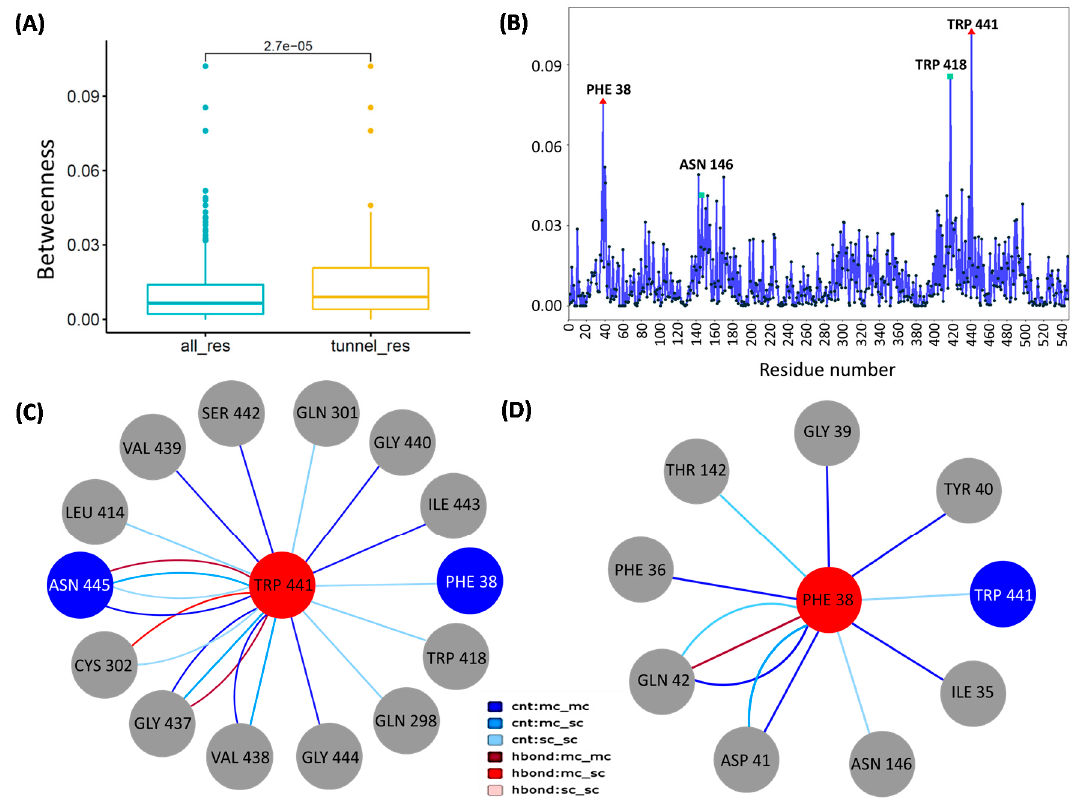
Figure 6. Analysis of residue interaction networks of CCM_06358. Note: ( A ) The distributions of betweenness for all residues and tunnel residues in CCM_06358. ( B ) The residue centrality profile of CCM_06358, while two tunnel bottlenecks with high betweenness are indicated by red triangles. ( C ) A subnetwok associated with the bottleneck residue of Trp441 in CCM_06358. ( D ) A subnetwok associated with the bottleneck residue of Phe38 in CCM_06358. Edges that represent contacts (cnt) are colored in blue; hydrogen bonds (hbond) are indicated in red, while darker and lighter colors stand for main chain (mc) and side chain (sc) atom interactions.